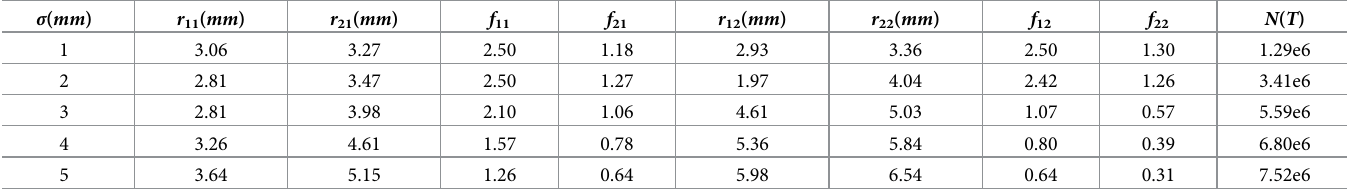
Table 4. Two two-step fractions, separately constrained.